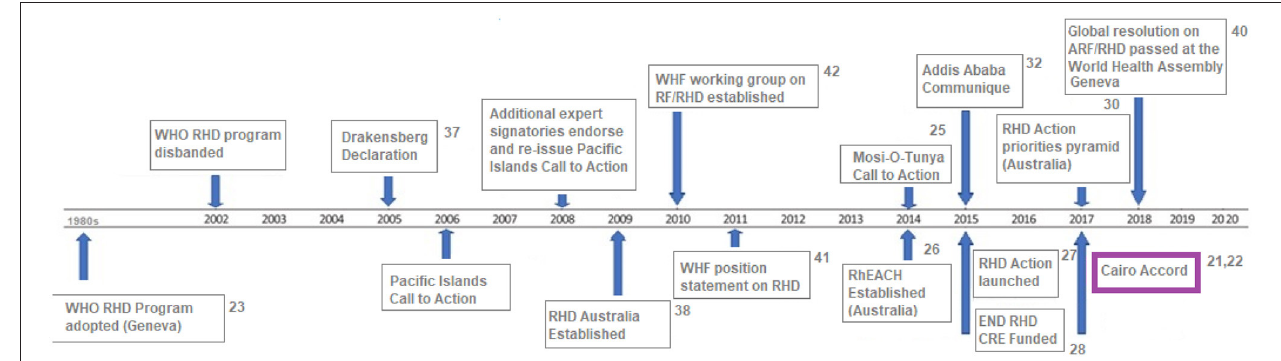
FIGURE 1 | Global and regional RHD-specific policy activity and calls to action, 1980 – 2020 [adapted from (23)].